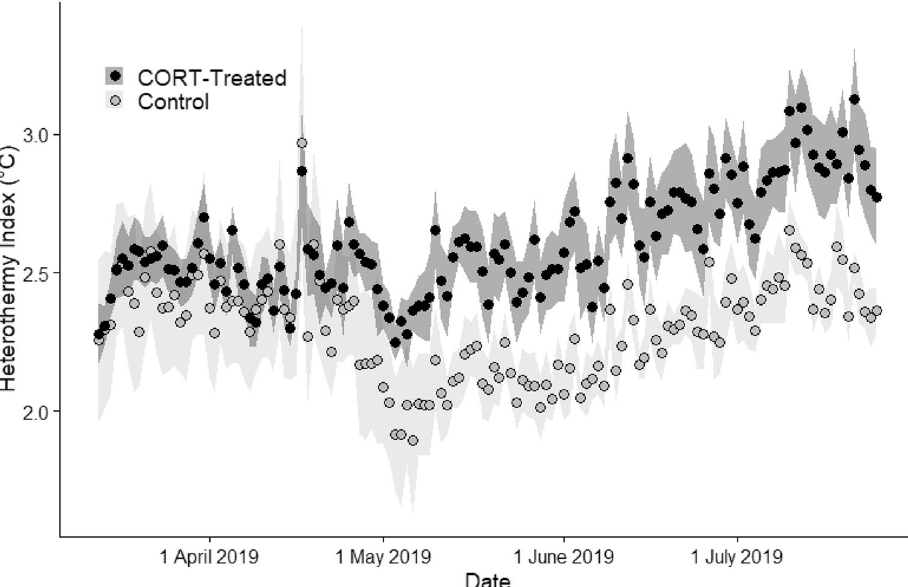
Figure 4. Heterothermy Index (HI) in banner-tailed kangaroo rats ( Dipodomys spectabilis ) implanted with a silastic implant either impregnated with corticosterone (CORT-treated; n = 6) or not (Control; n = 5). The points represent averages of the animals on each day and the shaded areas represent standard error. The large decrease at the beginning of May occurred under a new moon. While we cannot fully explain this decrease, the fact that it occurred in both treatment and control animals suggests the cause is environmental and not experimental. We reanalyzed the data after splitting the dataset into periods before and after 1 May 2019, but the results and interpretation were not changed.